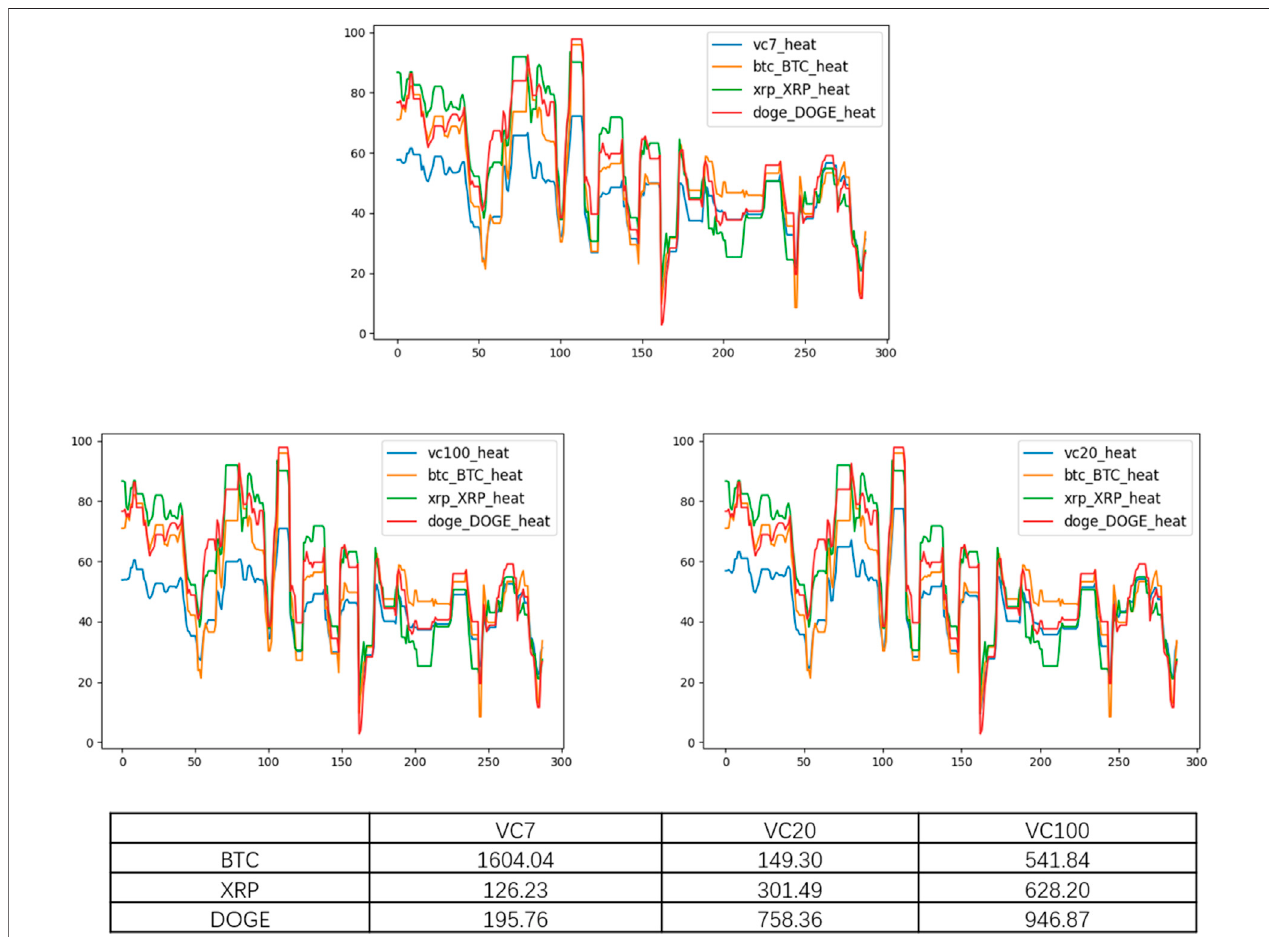
FIGURE 9 | Comparison of BTC, XRP, and DOGE popularity value with the three indexes on August 3.